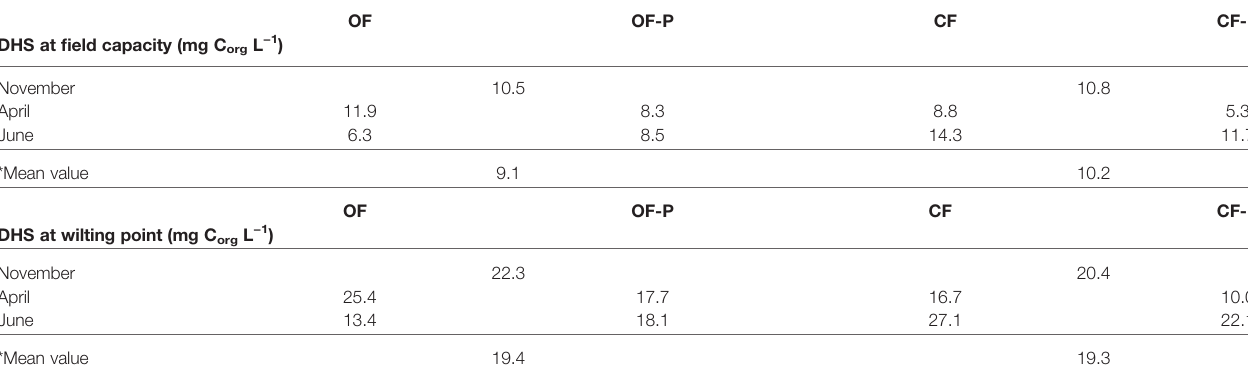
TABLE 2 | Estimated concentration ranges (mg C org L − 1 ) of soluble humic fractions (dissolved humic substances, DHS) in the soil solution of bare soils (OF and CF) and planted soils (OF-P and CF-P) at fi eld capacity and wilting point.